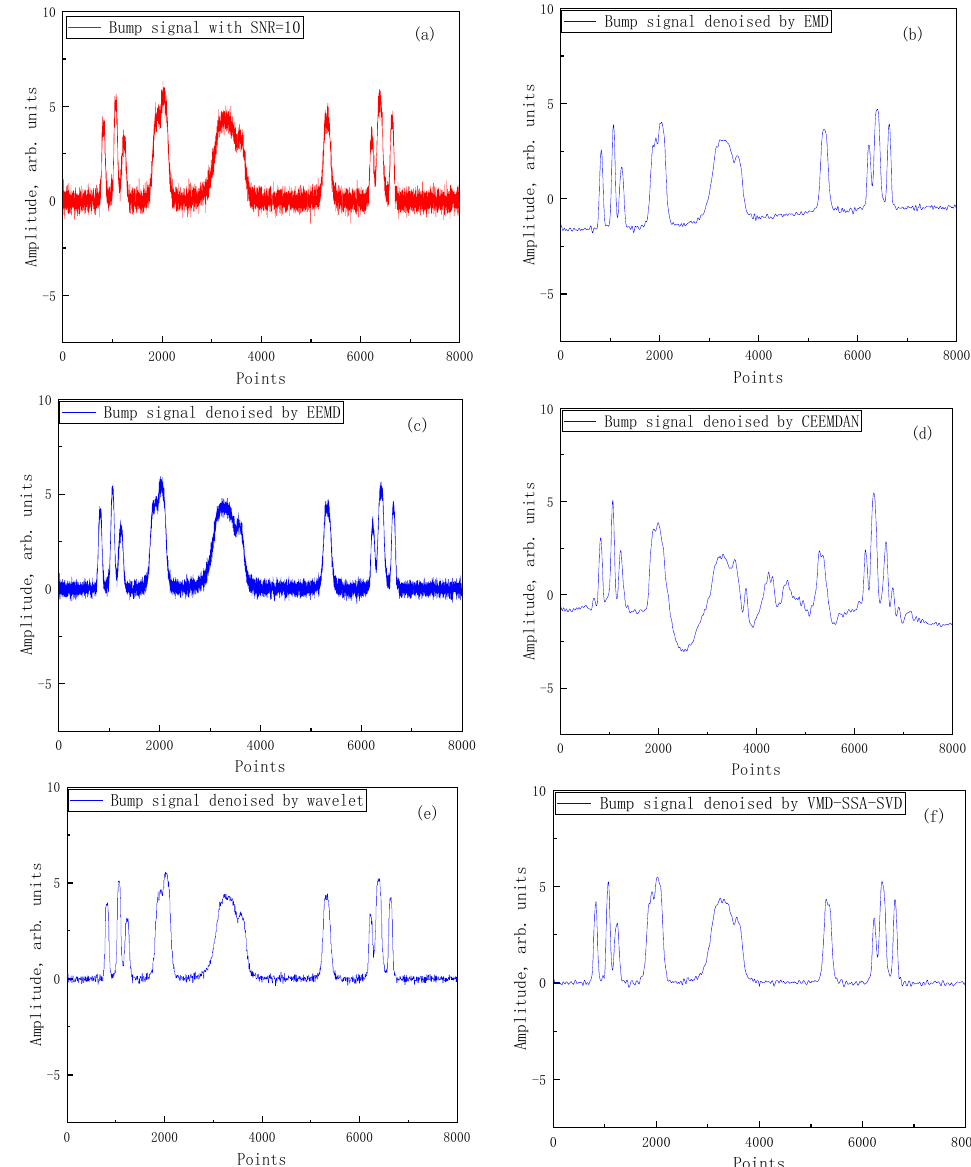
Figure 5. The simulated noise-reduction effects of Bump signals. ( a ) The Bump signal with SNR = 10. ( b ) The signal processed by the EMD method. ( c ) The signal processed by the EEMD method. ( d ) The signal processed by the CEEMDAN method. ( e ) The signal processed by the wavelet thresh- old method. ( f ) The signal processed by the VMD-SSA-SVD method.